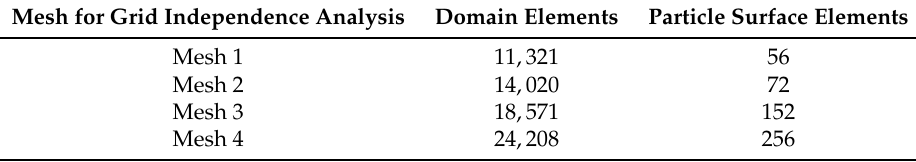
Table A2. Four meshes for grid independence analysis and for ∆ t = 1 × 10 − 5